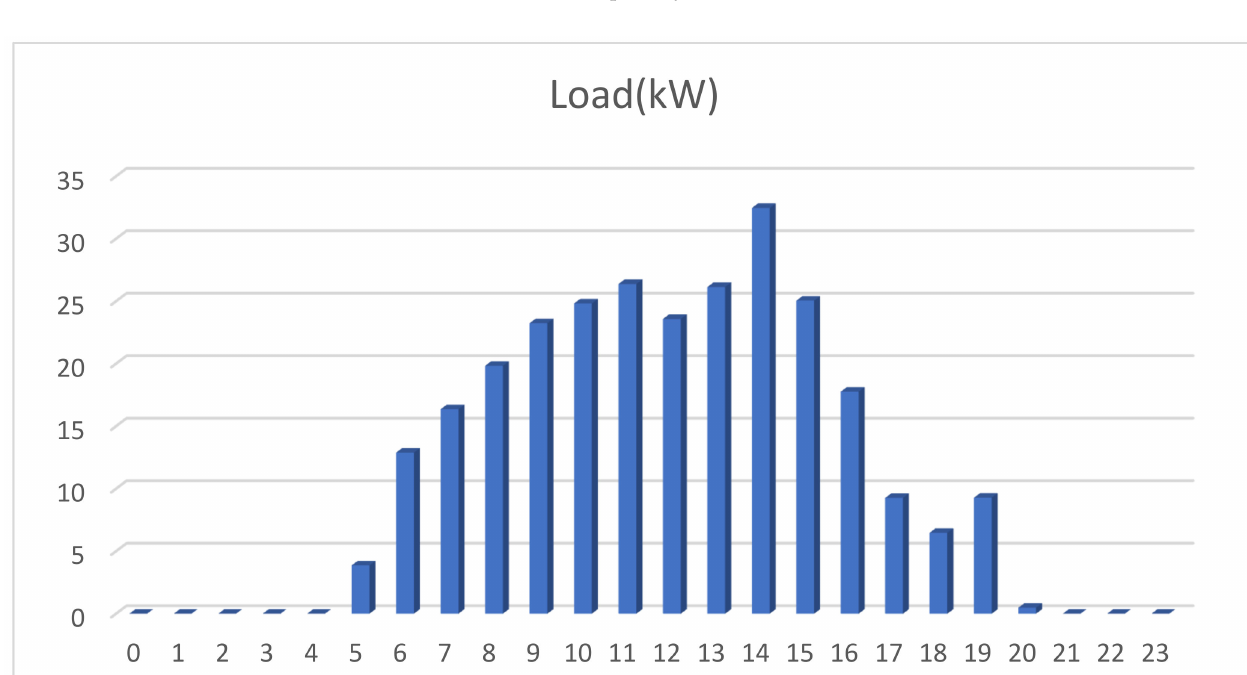
Figure 3. Number of EV visits per day.